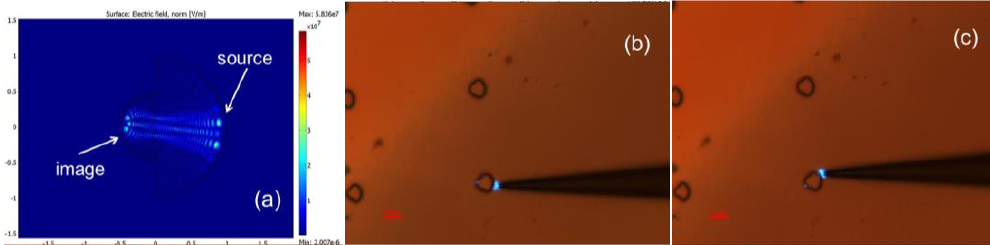
Figure 5. Operation of the magnifying Maxwell fisheye lens in reverse direction, which leads to image reduction. ( a ) COMSOL Multiphysics simulation of the fisheye lens image reduction using refractive index distribution corresponding to the experimental variation of the waveguide thickness. ( b , c ) Experimental testing of angular performance of the fisheye lens used in reverse direction. λ = 488 nm. Image reduction factor M = 1/2 is observed. The scale bar length is 5 μm in all images.